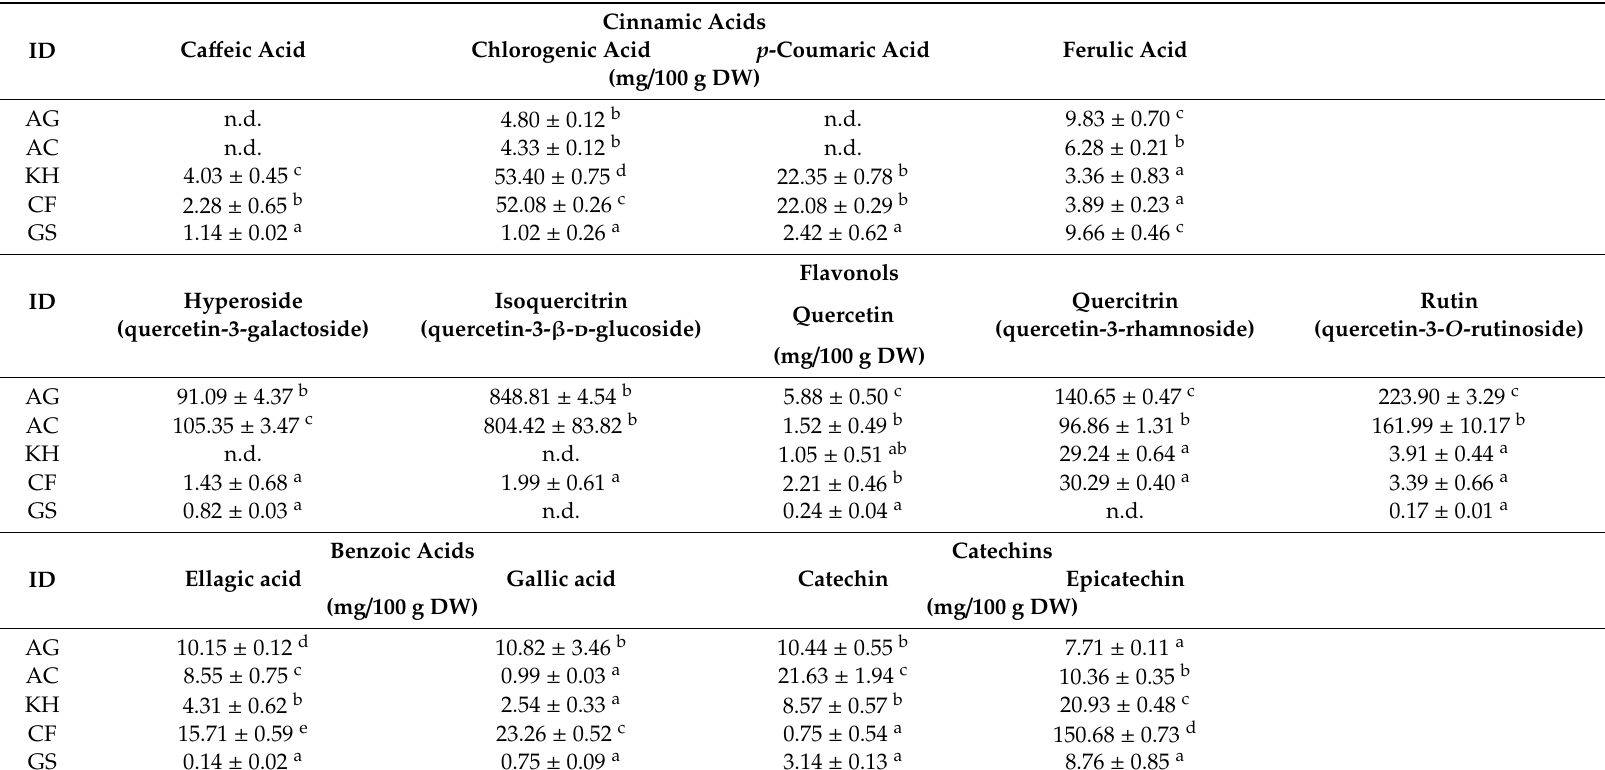
Table 2. Phenolic compound fingerprint of considered dried